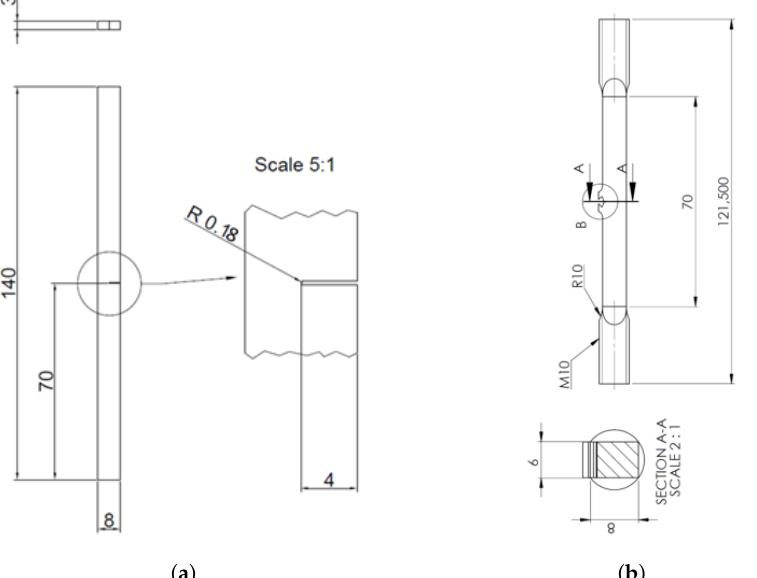
Figure 1. Specimen geometries used for testing (all units in mm). ( a ) Geometry of SENT specimen used for SSRT [25]. ( b ) Geometry of SENT specimen used for cyclic testing.